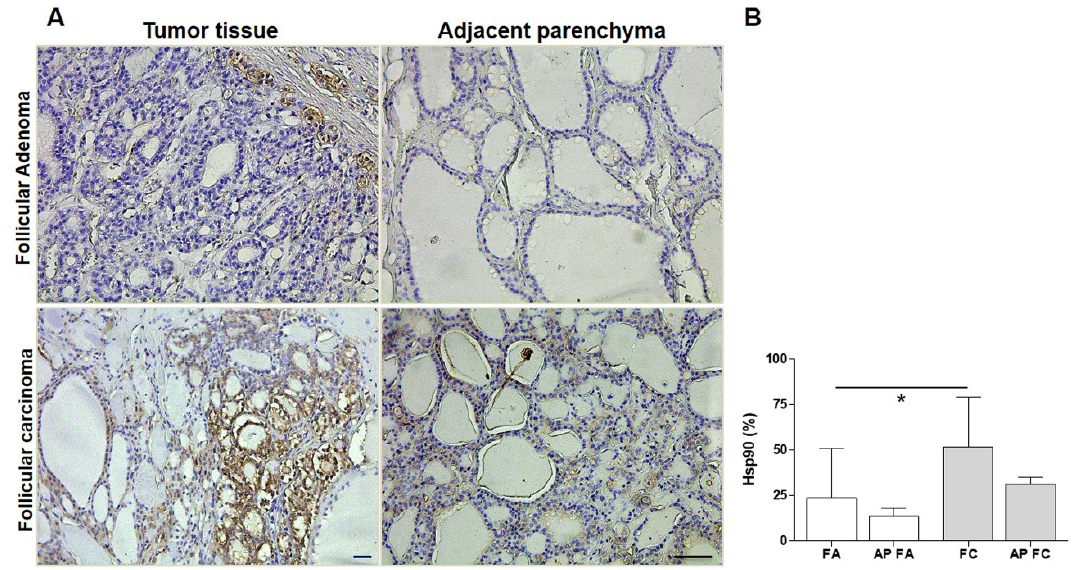
Figure 4. Hsp90 Immunohistochemistry: ( A ) Representative images of immunohistochemical results for Hsp90. Magnification 200 × ; scale bar 100 µ m. ( B ) The histogram shows statistical results for the immunohistochemical evaluation for Hsp90 in follicular adenoma (FA), adjacent parenchyma of follicular adenoma (AP FA), follicular carcinoma (FC) and adjacent parenchyma of follicular carcinoma (AP FC). Data are presented as the mean + SD. * p < 0.05.